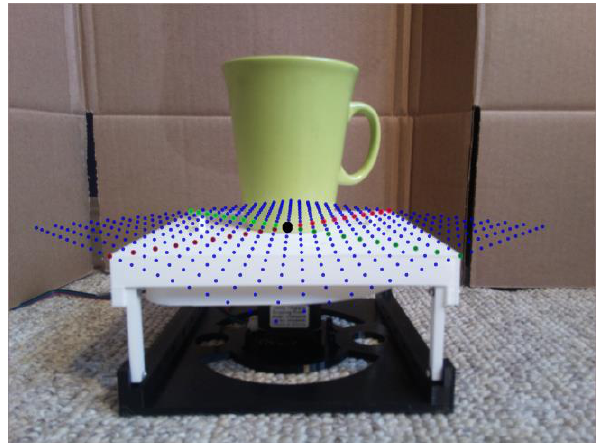
Figure 1 . Illustration of homography-based projection. Blue points are the projection of the world coordinates in the x-y plane. Red and blue points are the x and y axes in the world frame. The black point is the centre of the world frame.